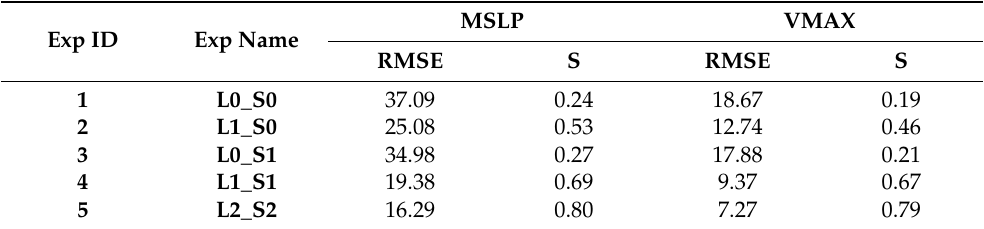
Table 2. Root mean square error (RMSE) and model skill (S) for the MSLP and VMAX from 5